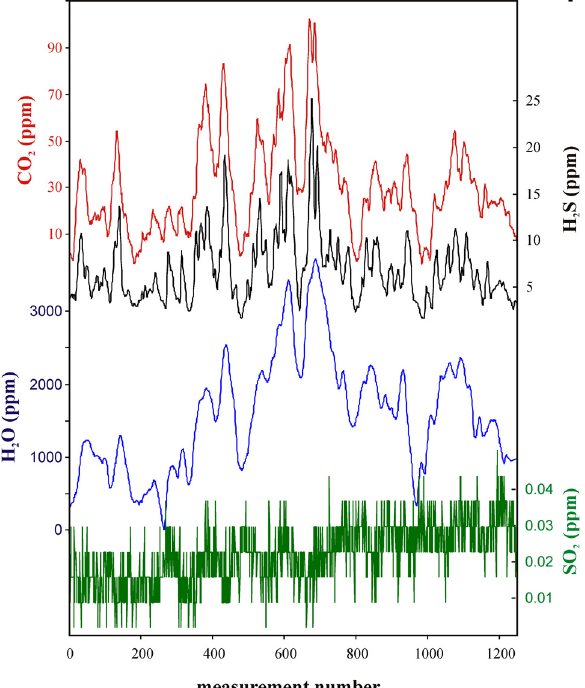
Figure 4. Time-series of gas concentrations in the near-vent plume of the Boiling Lake (taken at site BL; see Figures 1 and 3). A 40 min- utes long record (with 0.5 Hz acquisition rate) is shown.